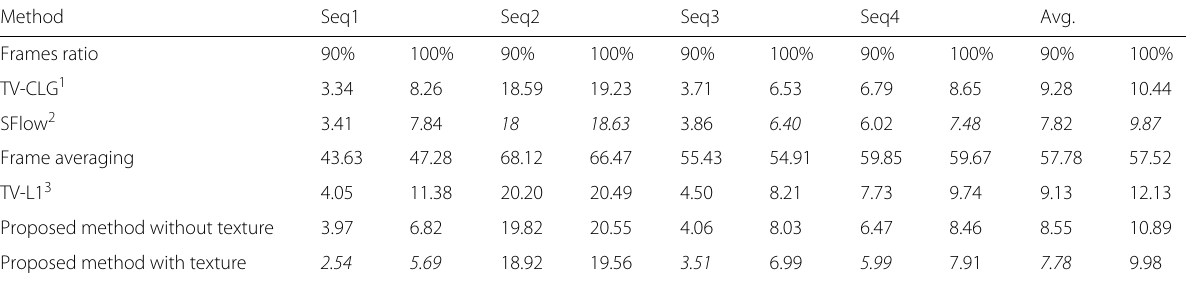
Table 2 Average MSE (10 − 3 ) for 90 and 100% of test sequences Method Frames ratio